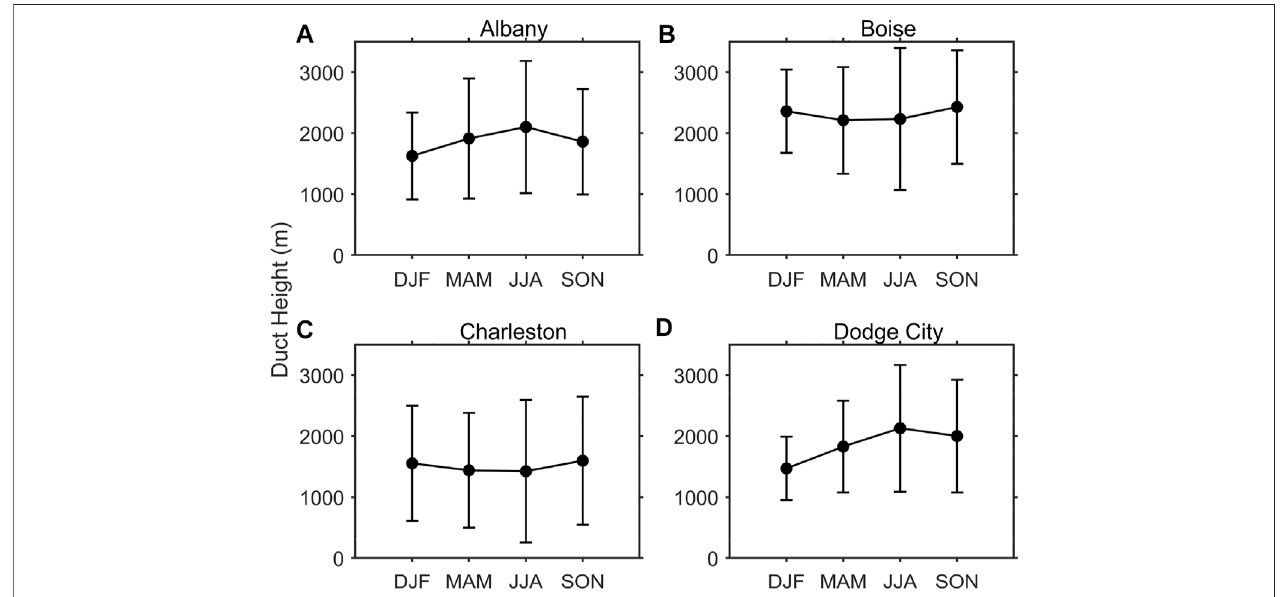
FIGURE7 | Seasonal variation ofthe duct height over the four stations. (A – D) Albany, Boise, Charleston and Dodge City.The vertical bars arethe standard errors.